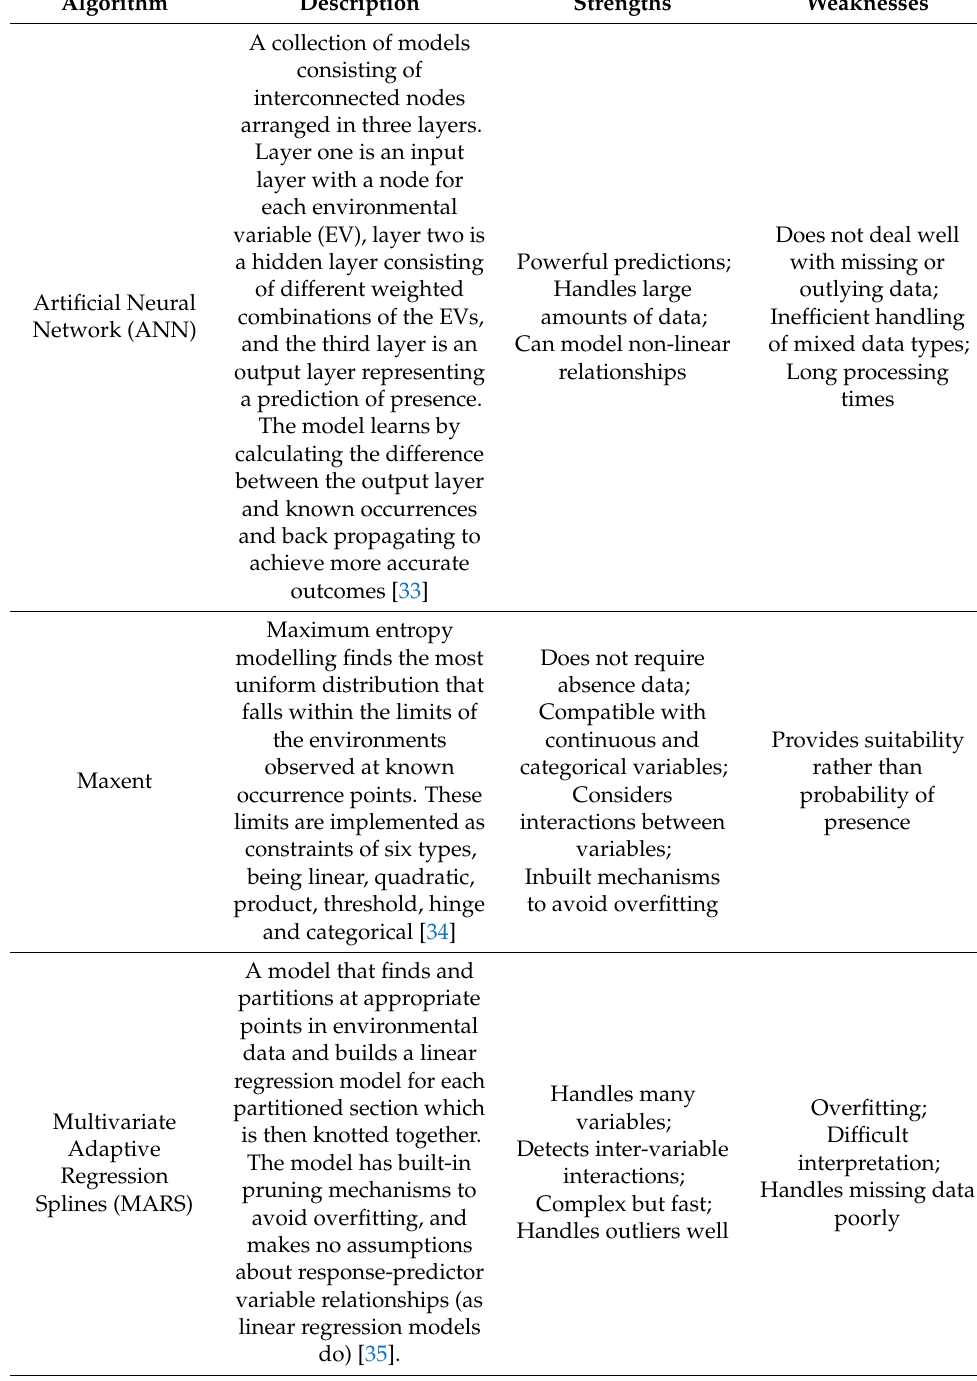
Table 1. Details of the three species distribution modelling algorithms used with associated descrip- tions, strengths and